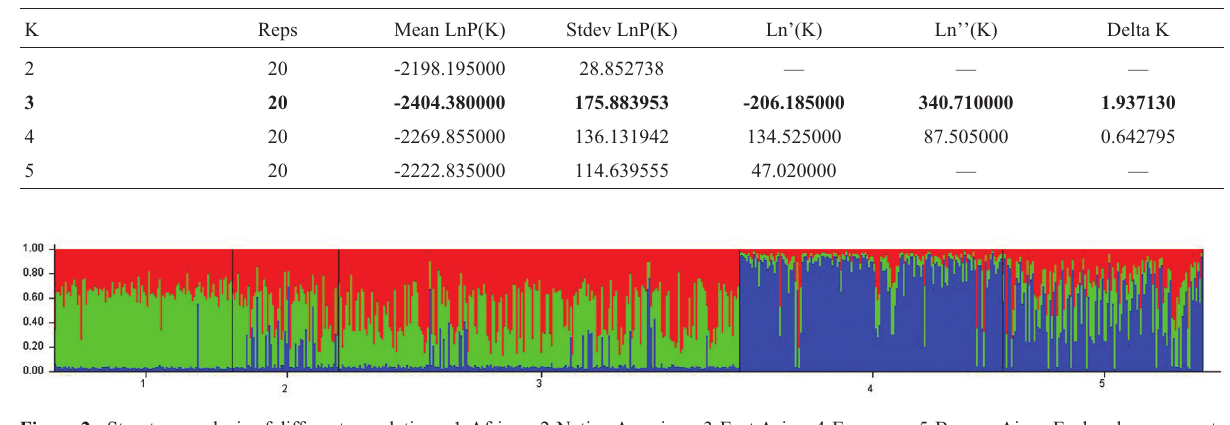
Figure 2 - Structure analysis of different populations: 1-African, 2-Native American, 3-East Asian, 4-European, 5-Buenos Aires. Each color represents an assumed ancestral population. Each individual is represented by a single vertical line divided into K segments of different colors.